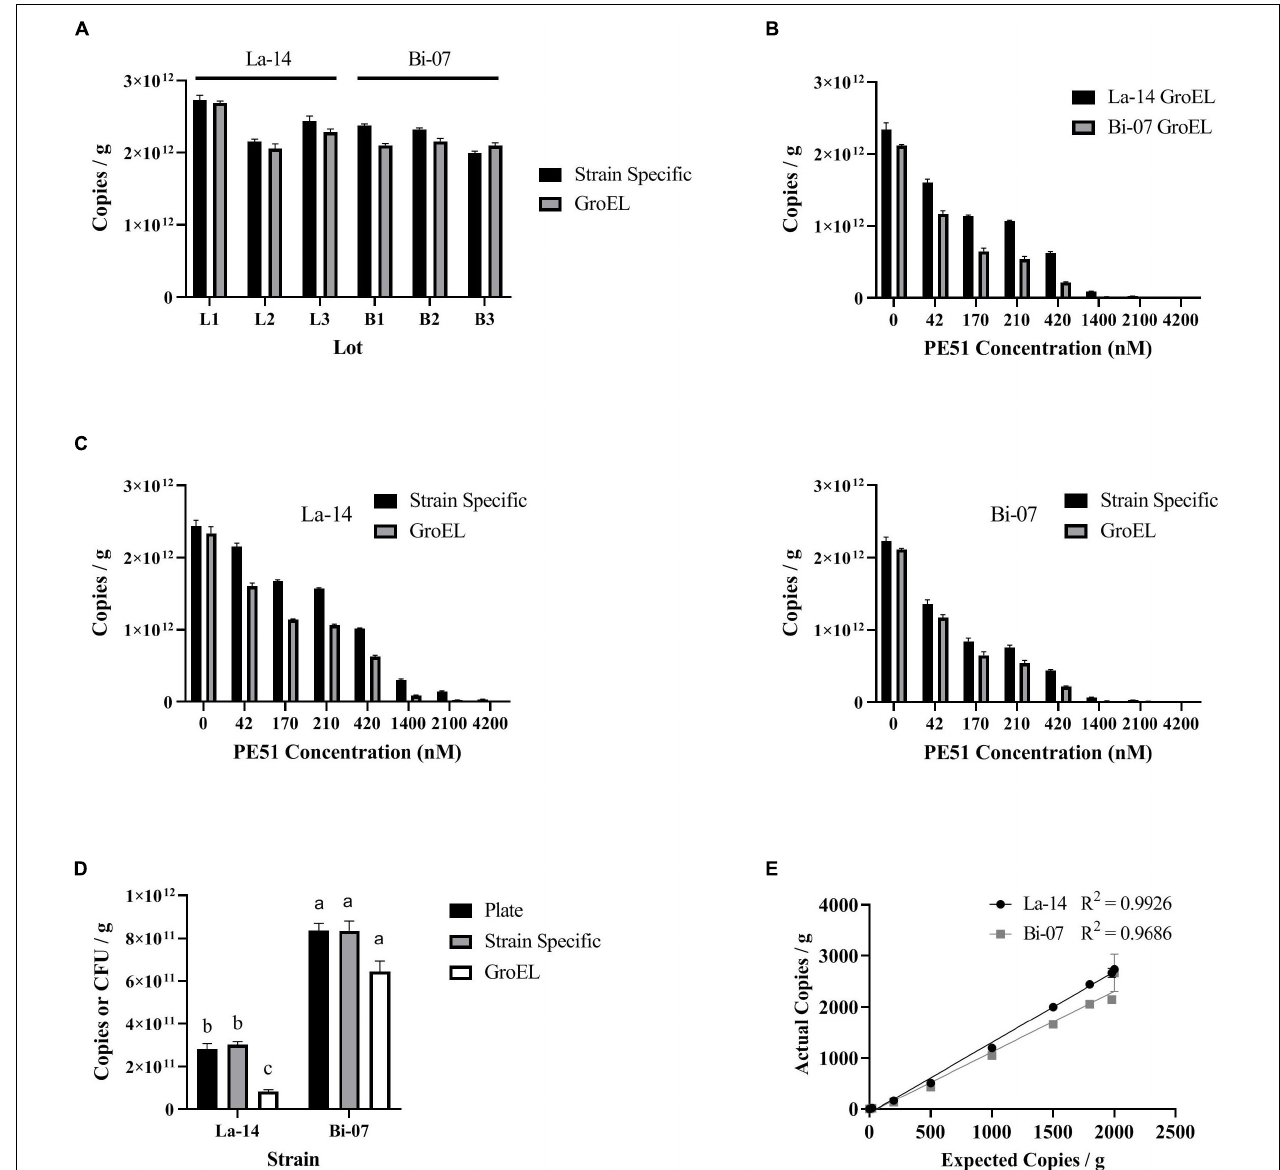
FIGURE 3 | Enumeration results based on ddPCR (using GroEL or strain specific assays) and plate count. (A) Comparison of pretreatment efficiency by assay target; (B) Comparison of PE51 efficiency by genus target; (C) Comparison of PE51 efficiency by assay target; (D) Comparison of v-ddPCR and plate count results; (E) Comparison of expected and actual v-ddPCR results. (A–D) correspond to the linear mixed effects models listed in Tables 1 , 2 ,